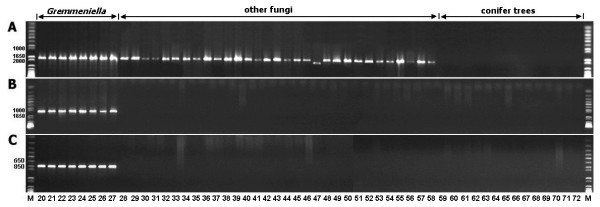
Specificity test of different PCR assays. A, amplification using fungal universal primer pair NS1/8; B and C, amplification using specific primer pairs NS.Grem3/4 and NS.Grem5/6, respectively. G. abietina isolates 1–19 were not shown on this gel due to space limitation. Nested PCR using NS.Grem3/4 and NS.Grem5/6 as inner primers gave amplification patterns identical to B and C, respectively. Fungal strains in each lane are in the order given in Table 1 and 2. M: 1 kb Plus DNA Ladder (Invitrogen).